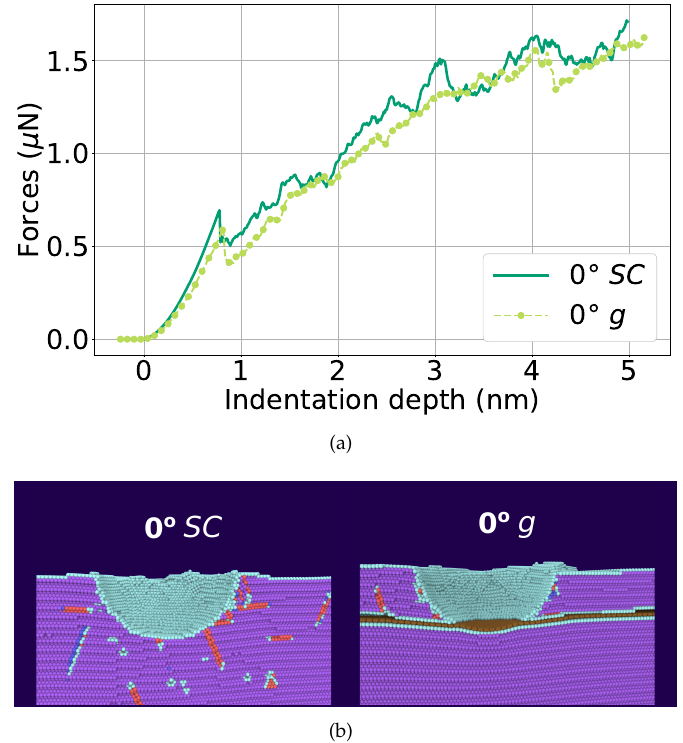
Figure 7. Comparison of the indentation into single-crystalline Ni (SC) with Ni containing graphene g at a depth of 3 nm. ( a ) averaged force–depth curves; ( b ) snapshots showing the microstructure at an indentation depth of d = 4.1 nm, immediately before dislocation nucleation in the lower Ni block. Atoms are colored according to common-neighbor analysis. Purple: fcc; red: stacking faults; cyan: other defects; brown: